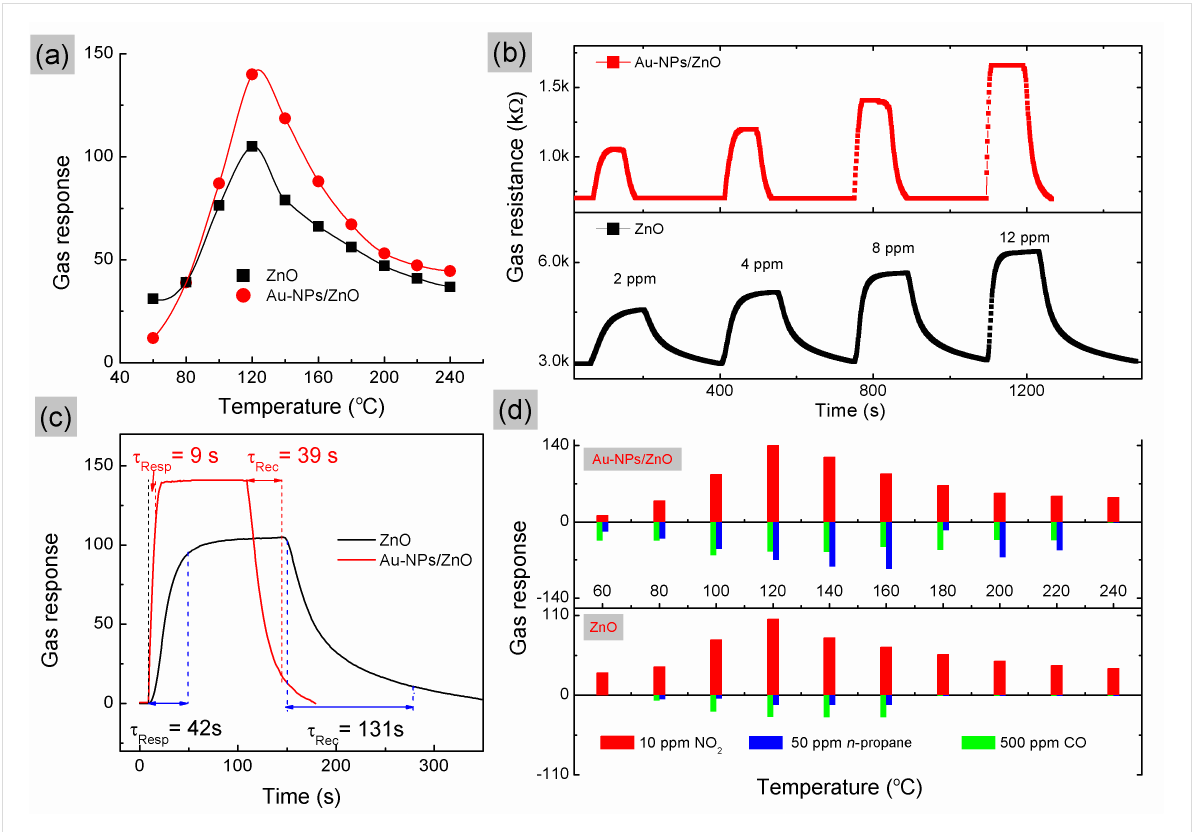
Figure 4: (a) The response of all sensors upon exposure to 10 ppm NO 2 at different operating temperatures. (b) Dynamic transient of resistance in response to NO 2 at 120 °C. (c) Response–recovery characteristics and (d) the responses of all sensors for different target